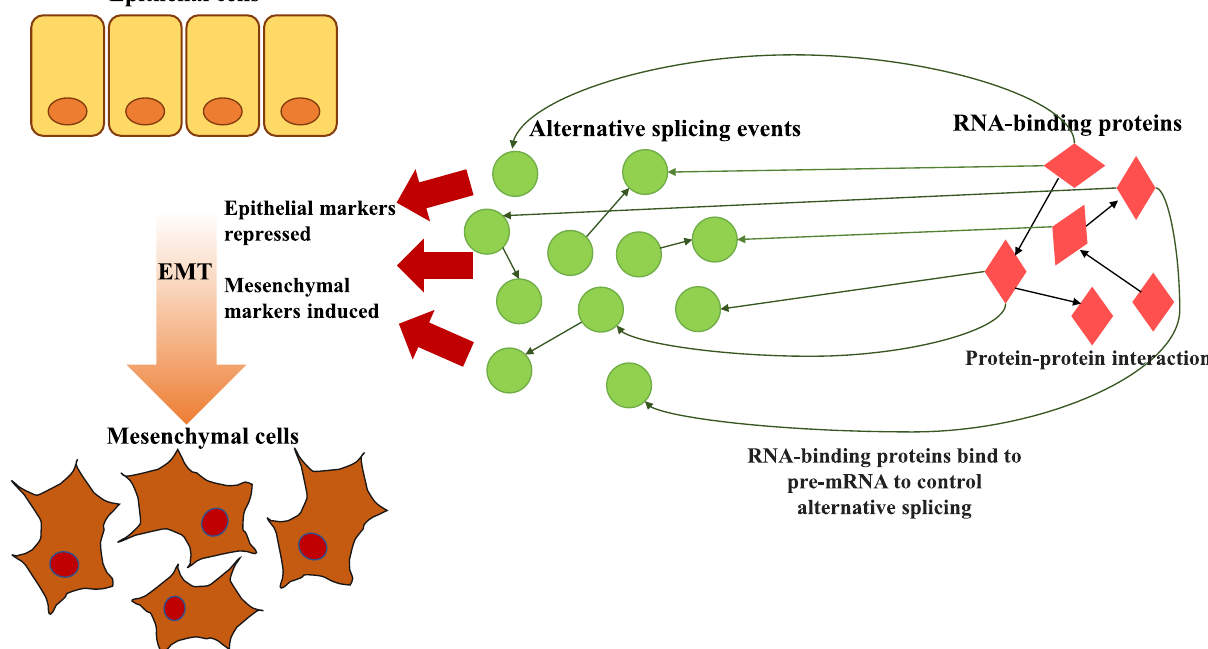
Fig 1. Pictorial representation of the EM transition process by incorporating alternative splicing events and RNA-binding proteins.